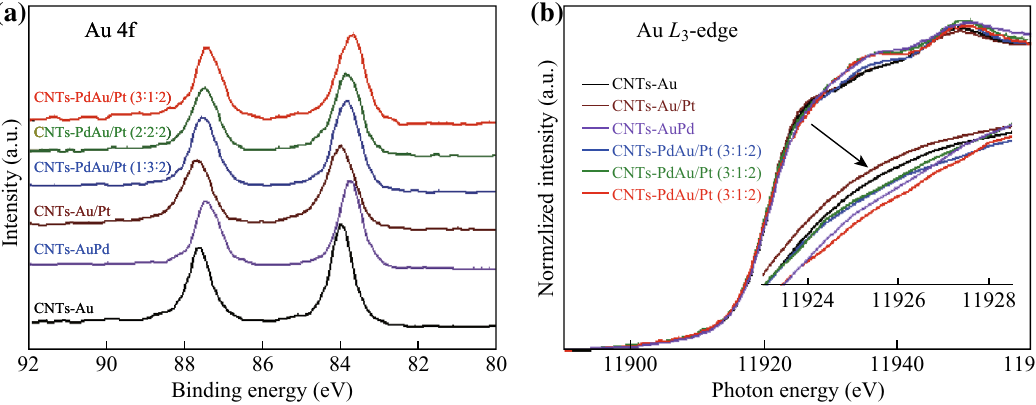
Fig. 4 a Au 4 f XPS spectra and b normalized Au L 3 -edge XANES spectra of CNTs-PdAu/Pt trimetallic NPs with different Pd/Au/Pt ratios, Au/ Pt bimetallic NPs, and Au NPs. The insets in b are magnified white line regions of as-obtained